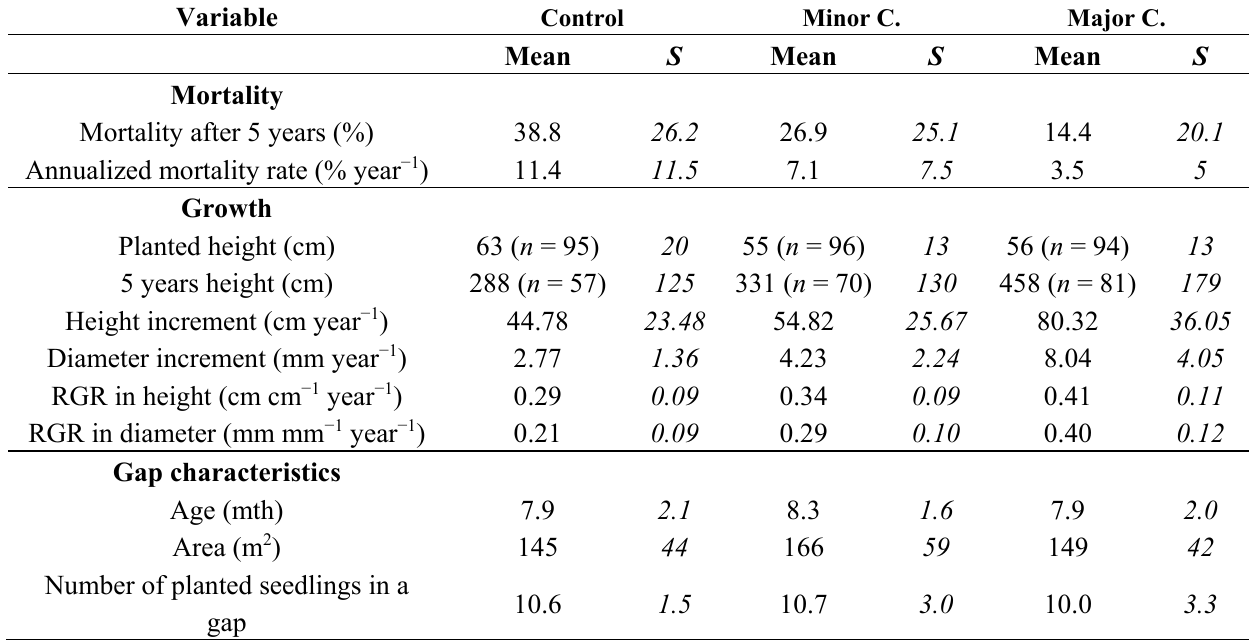
Table 2. Performance of P. elata seedlings according to silvicultural treatments in control gaps ( n = 9), in gaps with bi-annual clearance one-meter around the seedling (minor C., n = 9), and in gaps with bi-annual clearance of all competing vegetation (major C., n = 9). The mean and standard deviation (s) of mortality rate after five years, annualized mortality rate, height of seedlings at plantation and after five years, height and diameter increment, and relative growth rate in height and diameter are given for each silvicultural treatment. The number ( n ) of planted or survival seedlings is also given. The mean and standard deviation of gap age, size, and number of introduced seedlings are also